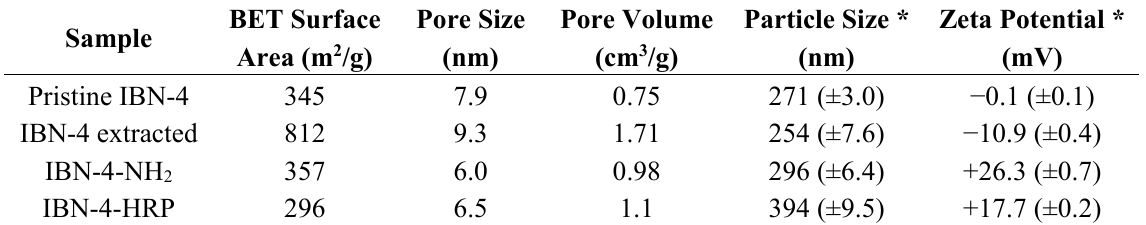
Table 1. Physical properties of the mesoporous